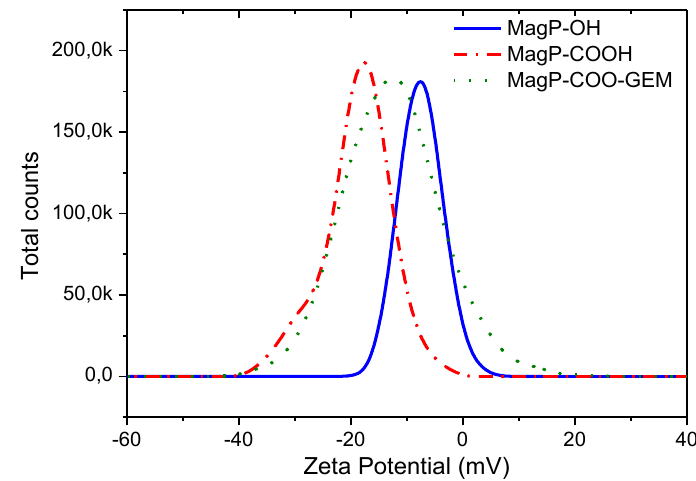
Figure 4. Zeta potential distribution of MagP – OH, MagP – COOH and Gemcitabine loaded MagP – COOH systems.